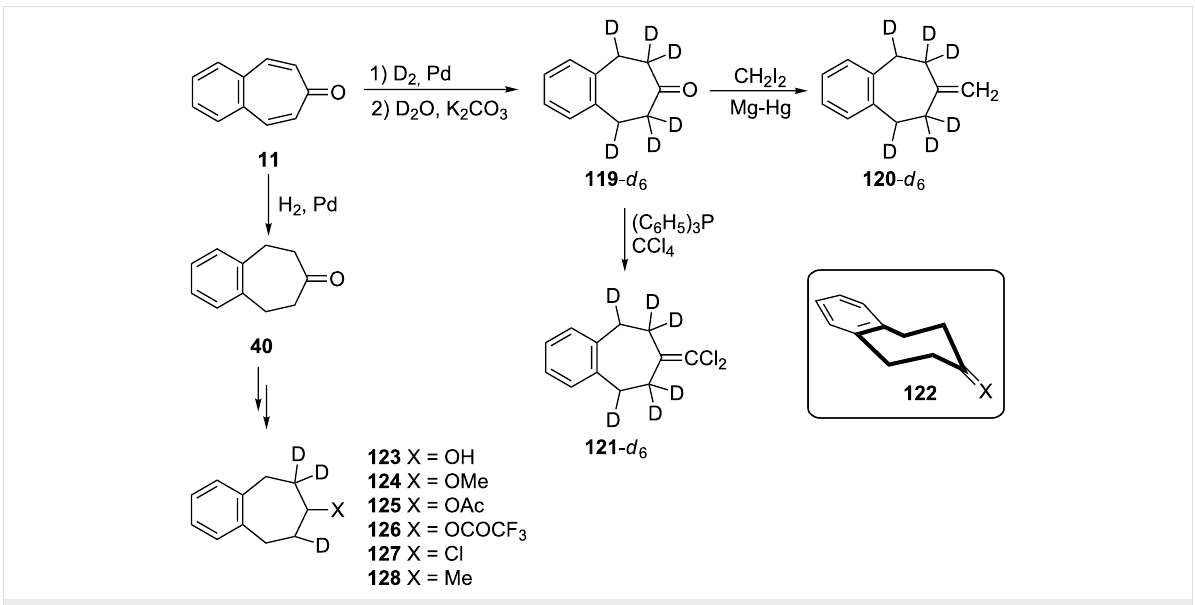
Scheme 21: A catalytic deuterogenation of 4,5-benzotropone ( 11 ) and synthesis of 5-monosubstituted benzo[7]annulenes 123 – 128